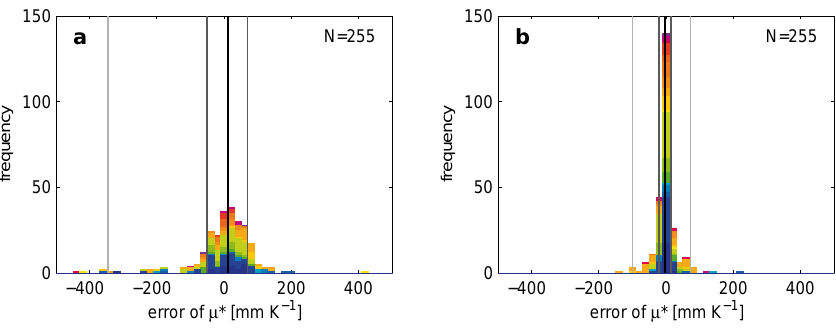
Fig. 3. Benefit of spatially interpolating t ∗ instead of µ ∗ ; (a) error distribution of µ ∗ if determined as the mean of µ ∗ of all other glaciers with mass balance measurements in the respective region; (b) error distribution of µ ∗ if determined by interpolation of t ∗ (see Sect. 2.1.9), both obtained during the leave-one-glacier-out cross-validation; vertical lines indicate the 2nd and 98th percentiles (light gray), 15th and 85th percentiles (dark gray), and median (black). Colors indicate the location of the respective glaciers (Fig.